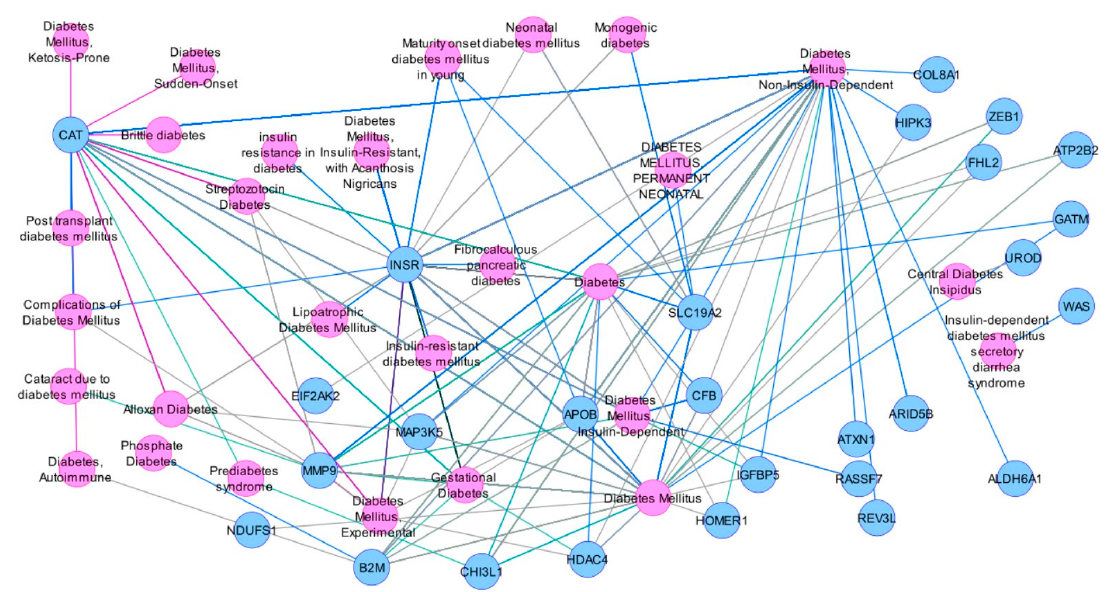
Figure 3. Disease–gene network for IR key metagenes for type 2 diabetes and related disorders, created using DisGeNET.